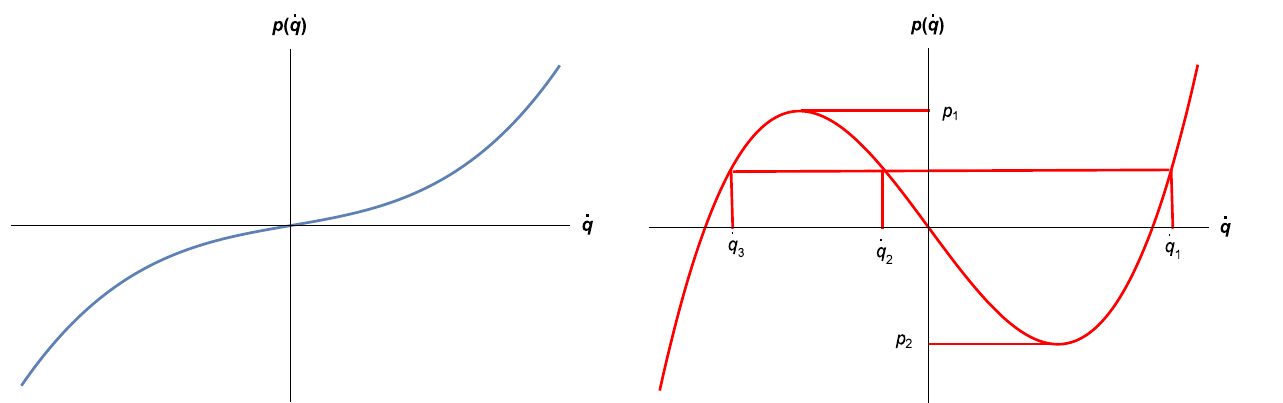
Fig. 2 For α > 0, Legendre map from ˙ q to p shows multivaluedness of inverse images ˙ q